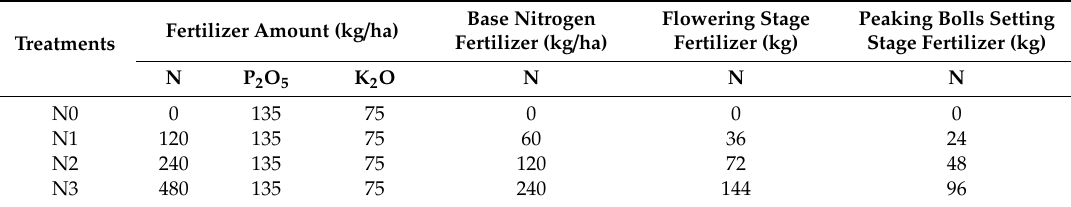
Table 1. Fertilizer rates under di ff erent nitrogen